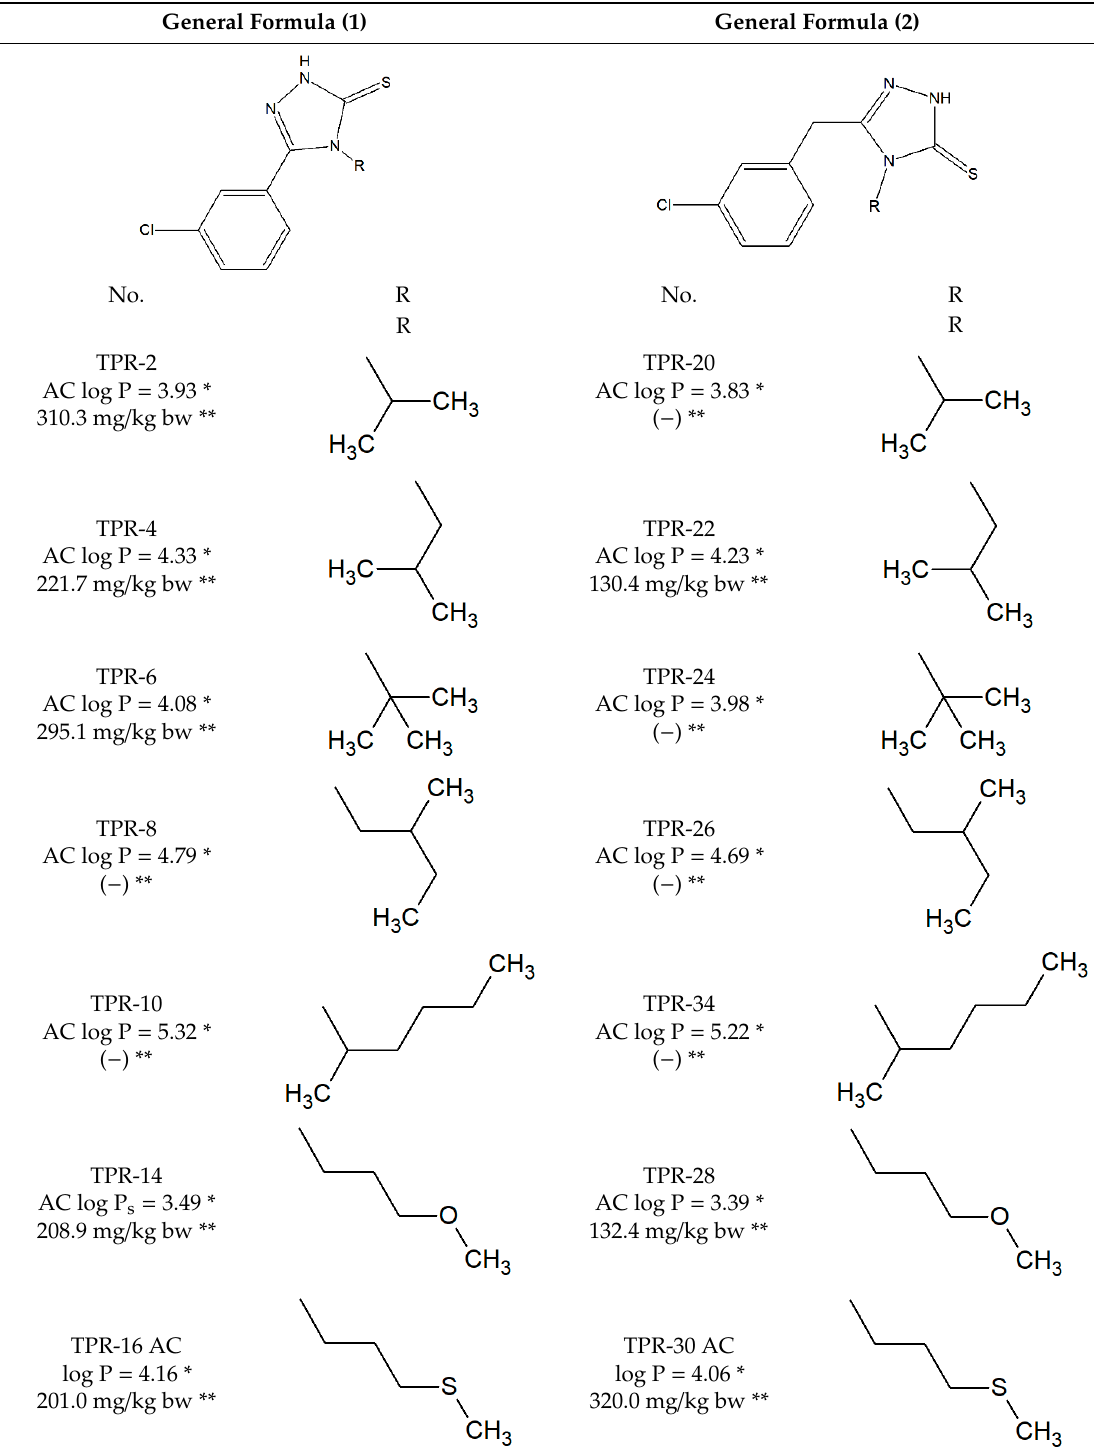
Table 1. Investigated compounds.